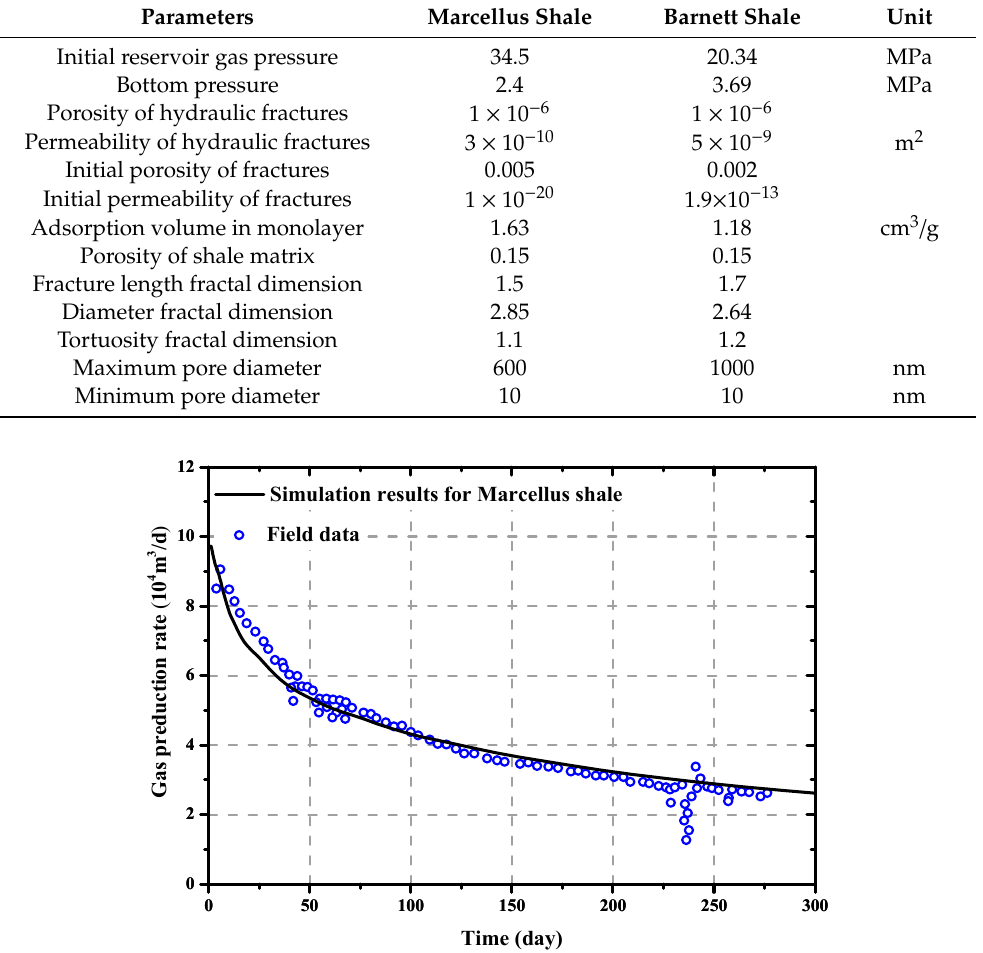
Figure 6. Comparison between our simulation results and the field data from the Barnett shale well. 4. Results and Discussions 4.1 Effects of Fracture Length Fractal Dimension Fracture length fractal dimension is a key parameter to a fracture network. This section will investigate the effects of fracture length fractal dimension on the variation of reservoir pressure and shale gas production. 4.1.1 Variation of Reservoir Pressure The variation of reservoir pressure with time is studied. Figure 7 shows the reservoir pressure distributions in the reservoir when these four fracture networks are used, respectively. The